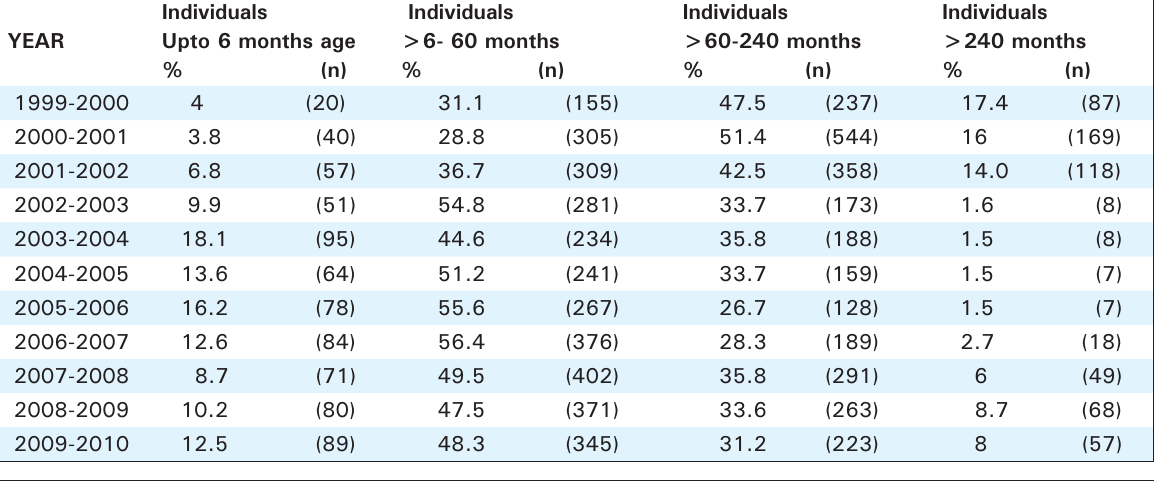
Table 3. Yearly distribution of the proportion of individuals in different age groups at the time of cleft lip repair (n=7334).